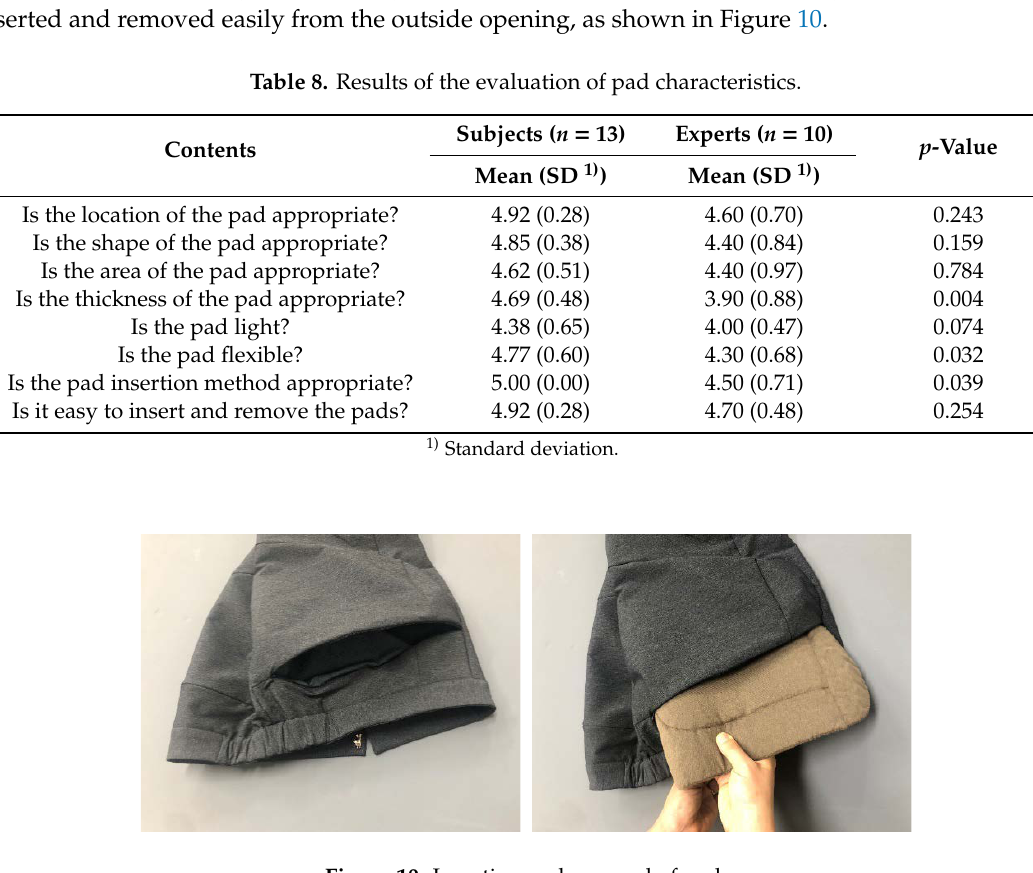
Figure 10. Insertion and removal of pad.